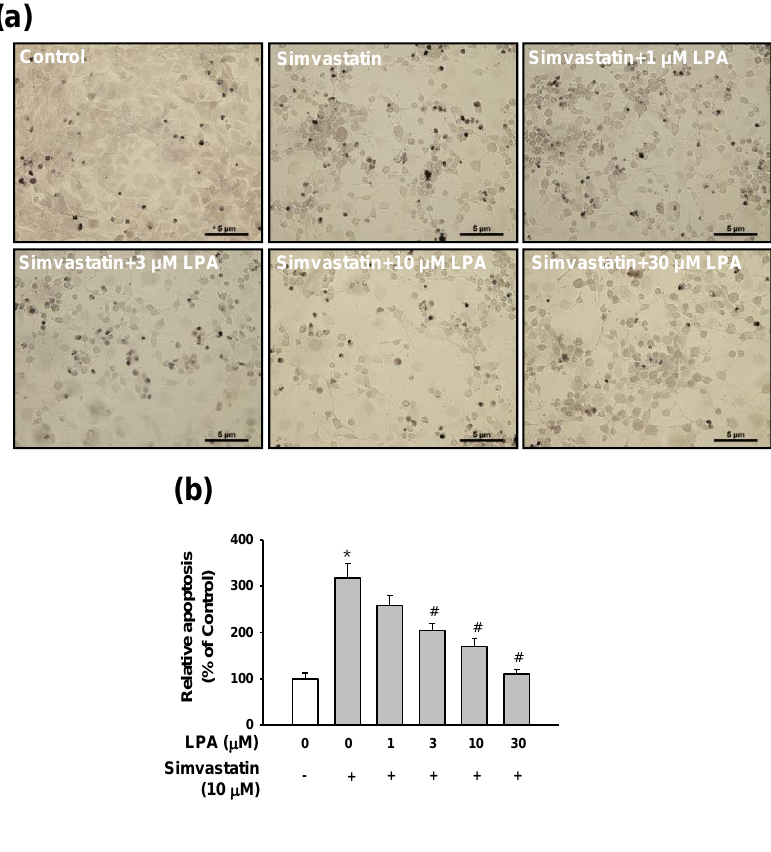
Figure 2. Effect of LPA on simvastatin-induced apoptosis in L6 cells. ( a ) Representative images obtained by each treatment. Cells were cultured on a cover glass in a 24-well plate and incubated with LPA (0 –30 μM) in the presence of simvastatin (10 μM) in serum free medium for 48 h, Apoptosis of cells was measured using a TUNEL assay. ( b ) Statistical graph obtained from panel (a). Brown spots indicate TUNEL-positive cells. Level of untreated control was considered as 100%. Data represent the means ± SEM (n = 6). * p < 0.05 vs. untreated control; # p < 0.05 vs. simvastatin alone. LPA (1 –30 μM) reduced the number of simvastatin (10 μM) -induced apoptotic cells in a dose- dependent manner. LPA at 30 μM almost completely recovered the apoptotic level induced by simvastatin (10 μM) ( Figure 2). 2.3. Effect of LPA on Caspase-3 and BAX Signals in L6 Cells Treated with Simvastain The anti-apoptotic effect of LPA mentioned above was confirmed by analyzing expression levels of caspase-3 and Bax as apoptosis-related proteins using an immunoblotting technique and caspase- 3 activity using an immunosorbent enzyme assay. As shown in Figure 3a , simvastatin (10 μM) elevated the level of cleaved caspase-3 (active form) and reduced the level of pro-caspase-3 (inactive form). LPA at 10 and 30 μM significantly reduced simvastatin (10 μM) -cleaved caspase-3 level. Bax e xpression level increased by simvastatin (10 μM) was also attenuated by treatment with LPA at 10 and 30 μM ( Figure 3b ). In addition, simvastatin (10 μM) significantly increased caspase -3 activity. Such increase was significantly reduced by treatment with LPA at 3 –30 μM ( Figure 3c). Furthermore, LPA (10 μM) -reduced simvastatin (10 μM) -increased caspase-3 activity in L6 cells; this effect was attenuated by treatment with Ki16425 (5 μM), an inhibitor of LPA receptor ( Figure